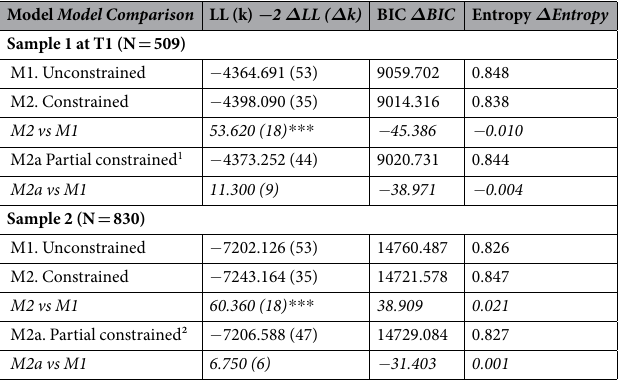
Table 2. Models for the gender invariance of the latent profiles in Sample 1 and Sample 2. LL = Log-likelihood; − 2 Δ LL = Log-likelihood ratio statistic; k = number of parameters; BIC = Bayesian Information Criterion; 1 Free to vary: SADNESS, CARING, and FEAR; 2 Free to vary: SADNESS, CARING, FEAR, and PLAYFULNESS;